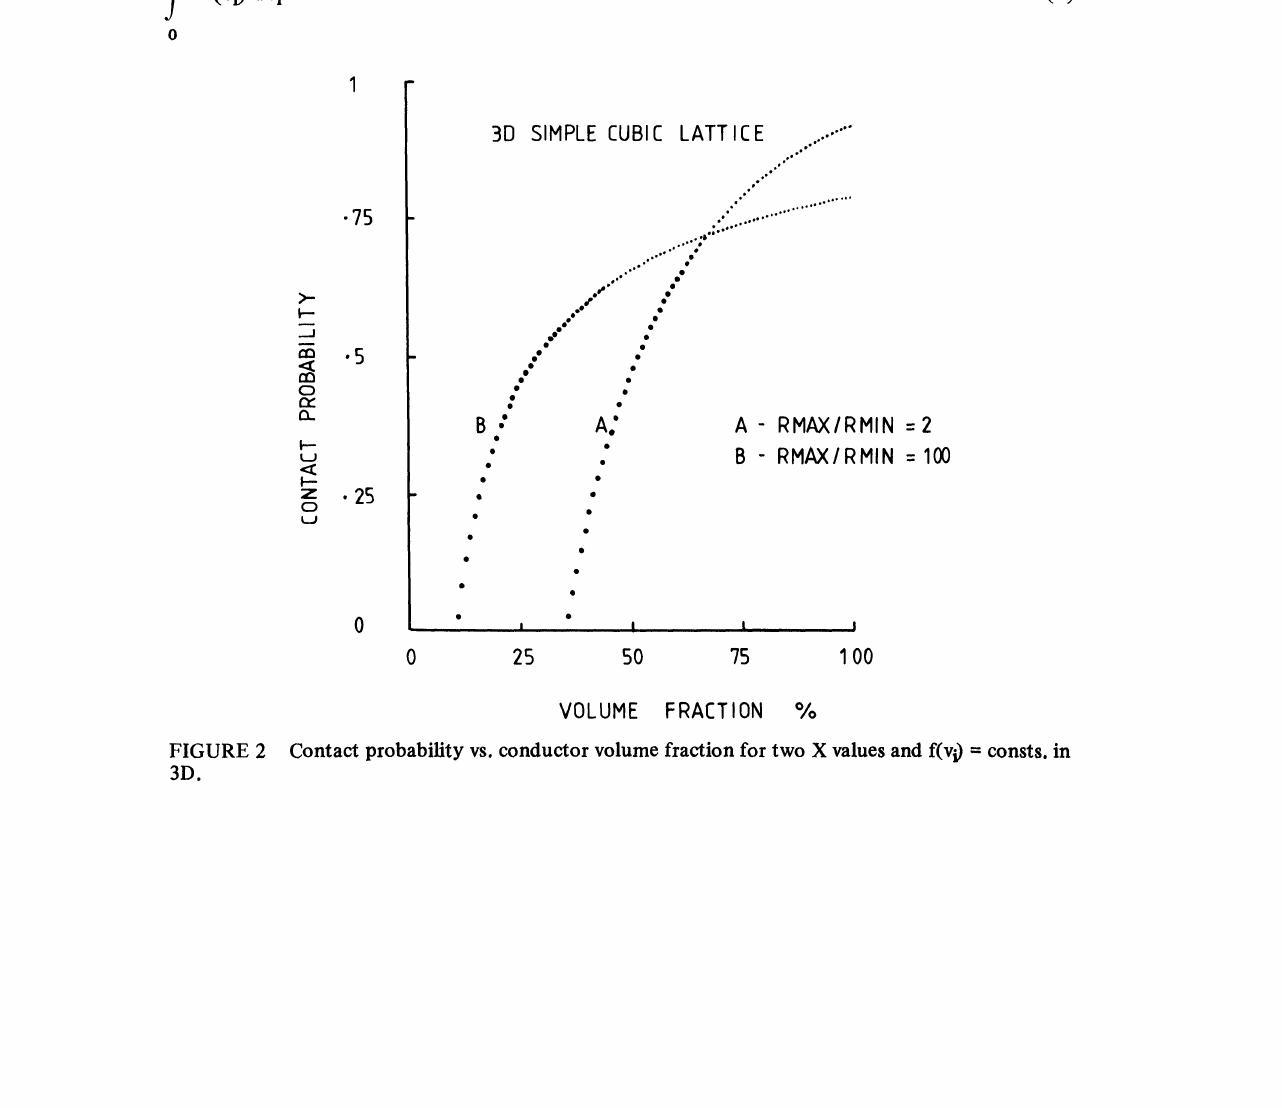
train, r -r rj rmctx. radius FIGURE Probability distribution of particle radius in a many-particle system.